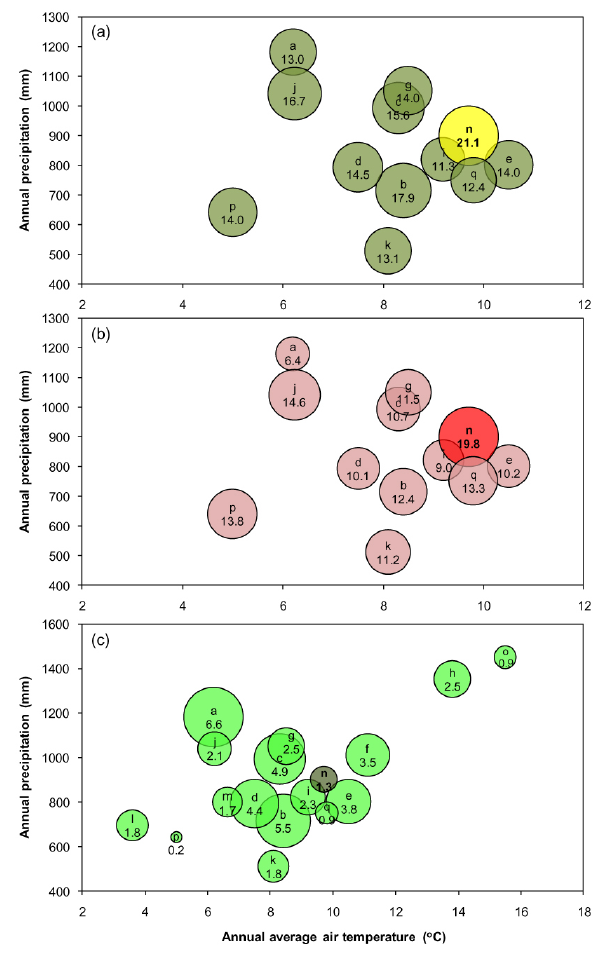
Fig. 9. Average annual (a) gross primary productivity (GPP), (b) ecosystem respiration ( R e ) and (c) net ecosystem productivity (NEP) estimates from temperate deciduous forests across the globe in MgCha − 1 yr − 1 , plotted by site annual mean air temperature and precipitation. Site descriptions are given in Table 4, Wytham Woods is highlighted in each